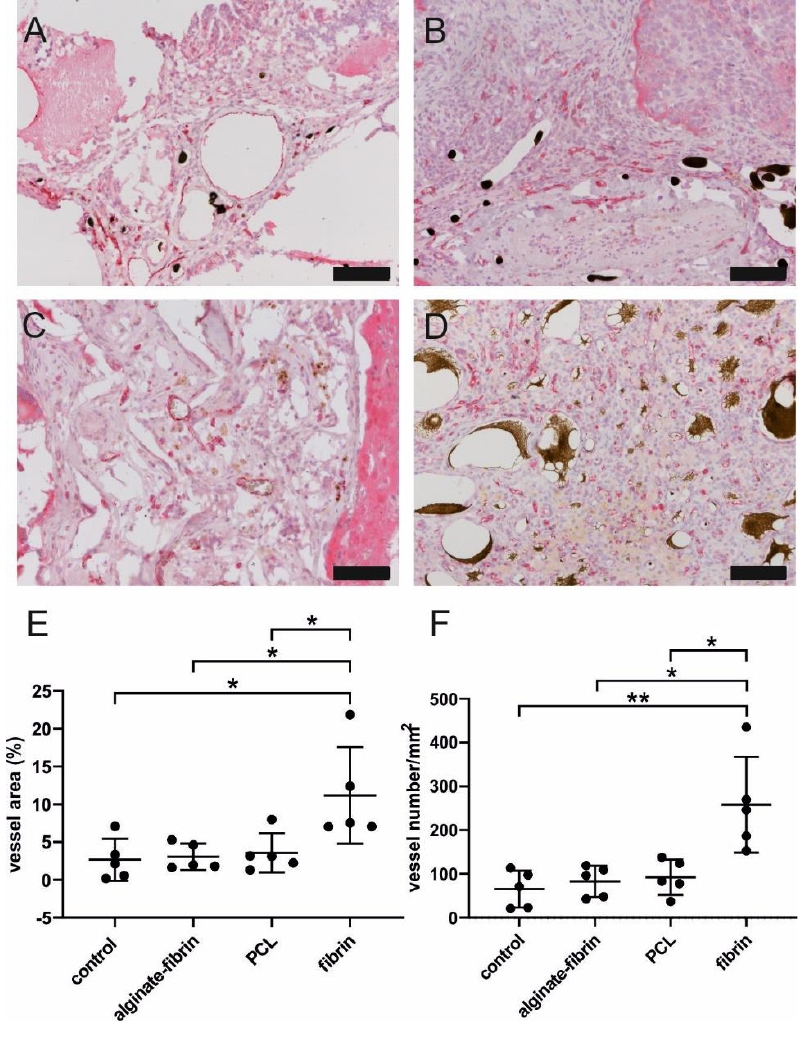
Figure 7. Vascularization of constructs. Representative microscopic images of CD31-immunohisto- chemistry staining of control ( A ), alginate – fibrin ( B ), PCL ( C ), and fibrin ( D ) groups. Scale bar 100 μm. Quantification of area per vessel ( E ) and vessel number per ROI ( F ) by CD31 staining. * p < 0.05, ** p < 0.01.